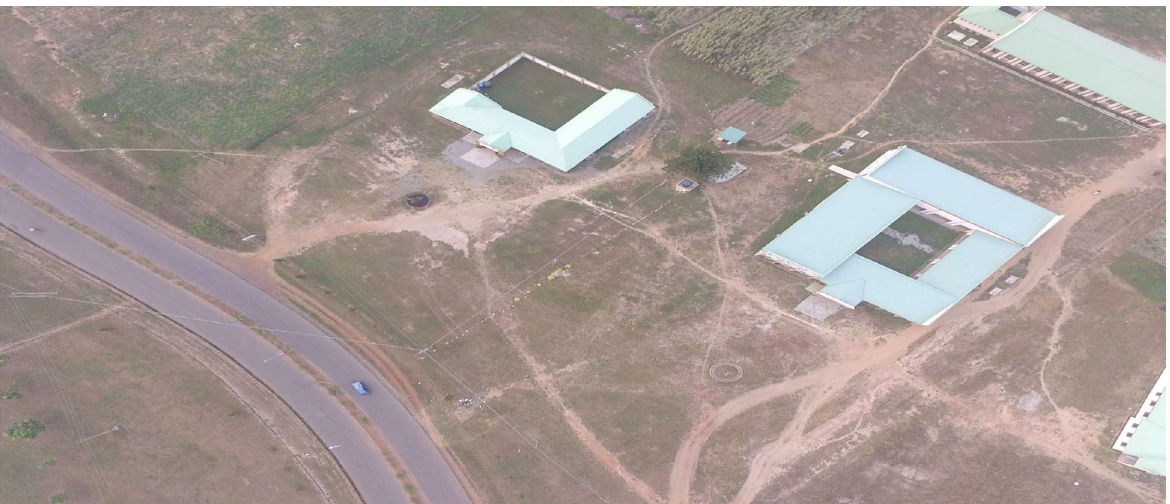
Figure 4b: UAV acquired image of part of FUTMinna, Main Campus (floating